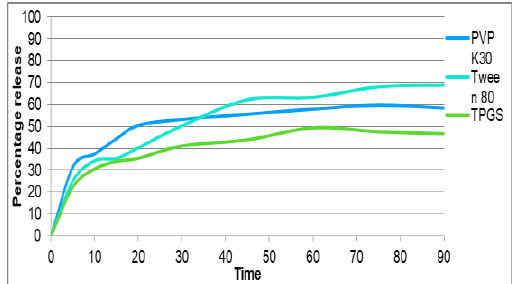
Figure 3. Influence of stabilizer type on release